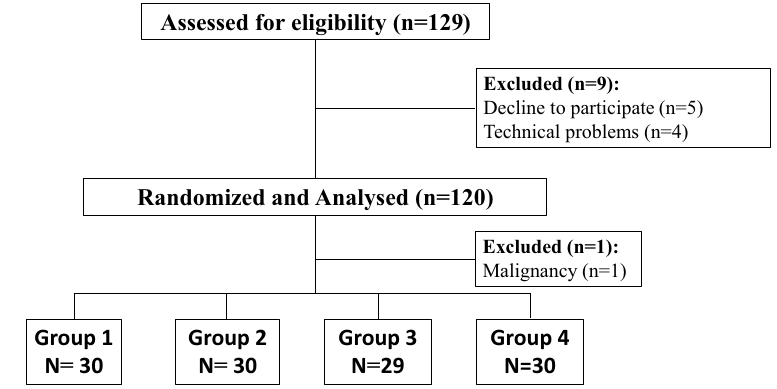
Figure 1. Patients enrolment.